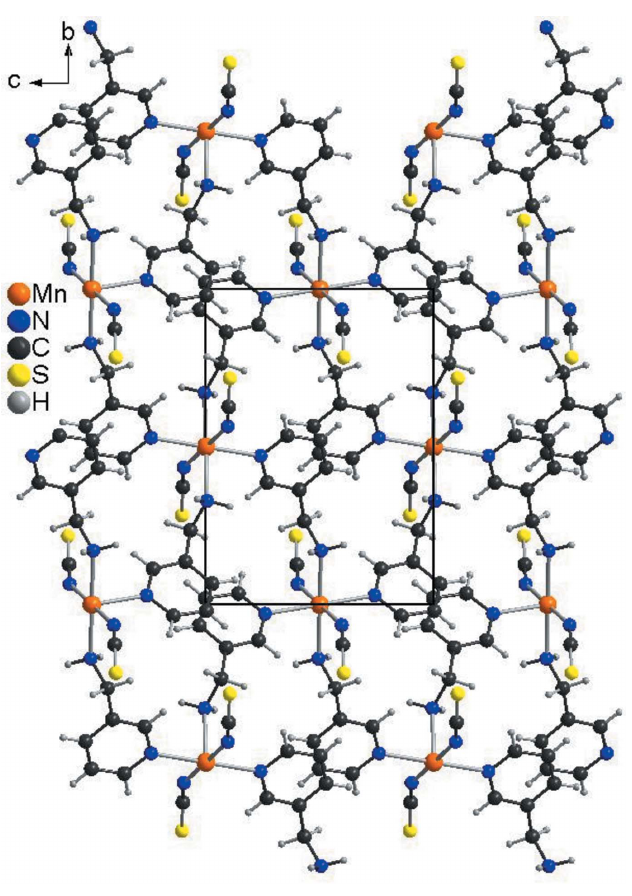
Figure 3 Crystal structure of the title compound in a view along the crystal- lographic b axis. Intermolecular N—H (cid:2)(cid:2)(cid:2) S hydrogen bonds are shown as dashed lines.